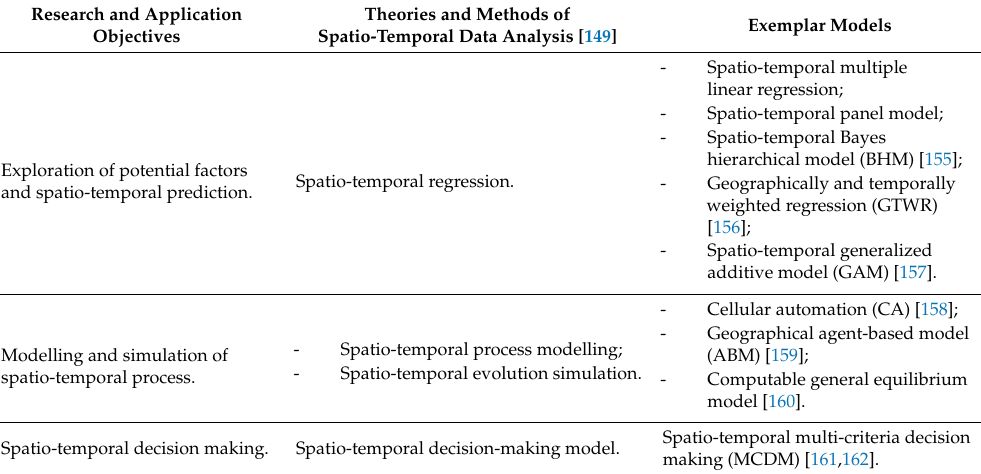
Research and Application